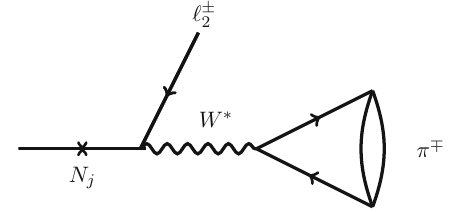
Fig. 10 Feynmann diagram for the decay process N → (cid:2) ± π